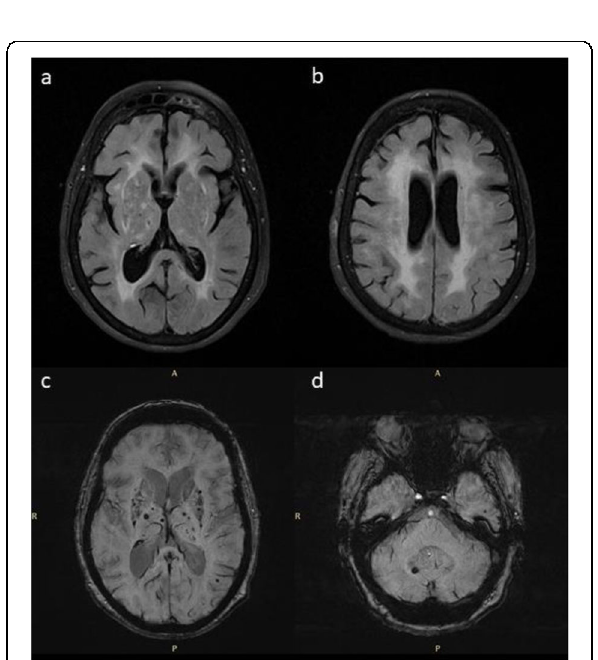
Fig. 2 (abstract P188). brain MRI scans: a-b) axial FLAIR sequences, showing diffuse white matter hyperintensity, including external capsules. C-d) Susceptibility-weighted imaging (SWI) showing hemosiderin-depositions in the basal ganglia (thalami included) and in the right